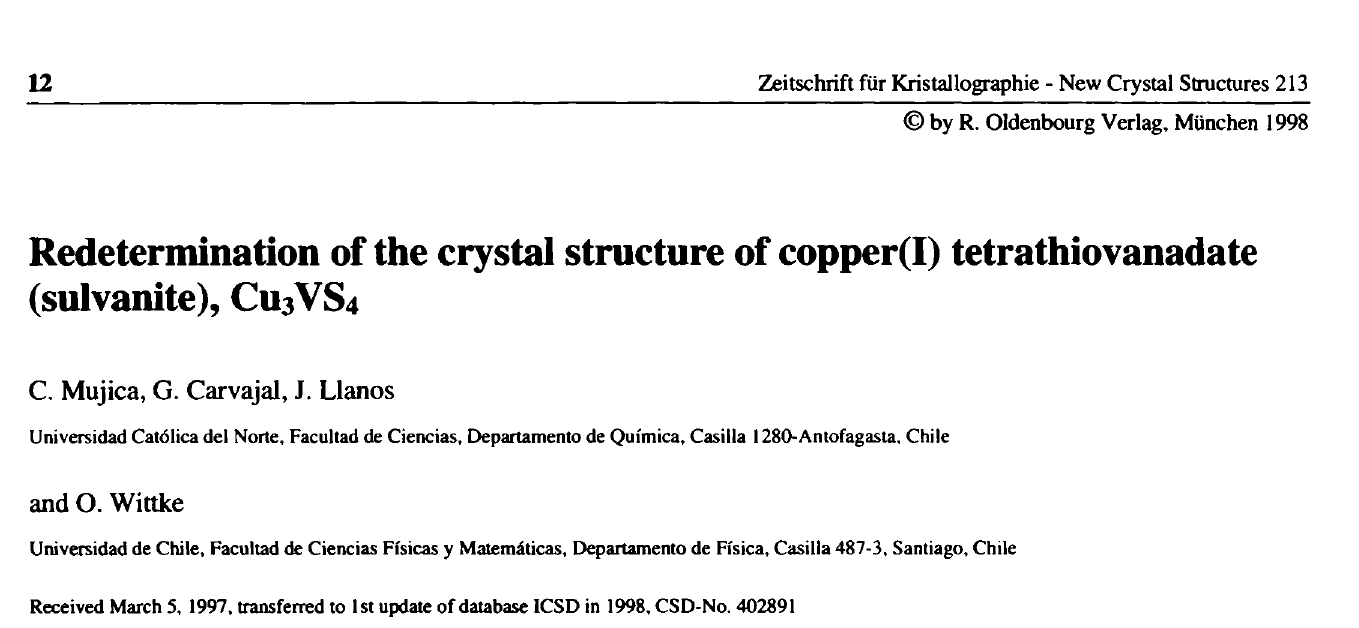
Table 1. Parameters used for the X-ray data collection Crystal: Wavelength: μ: Diffractometer: 2втах: